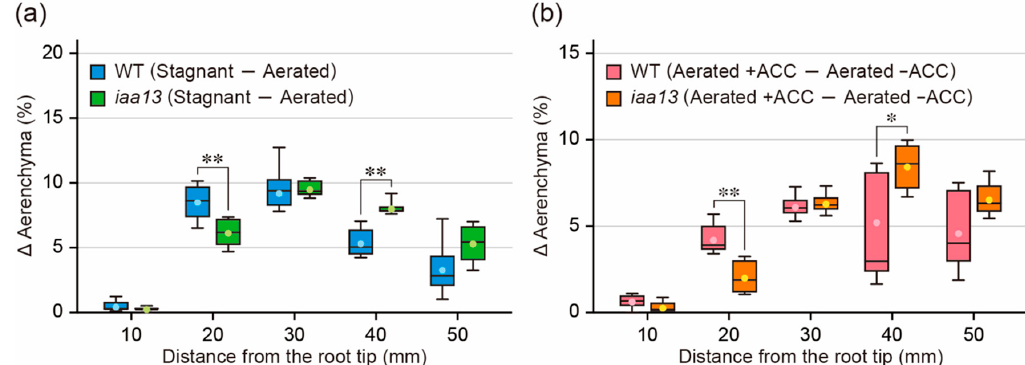
Figure 3. Di ff erences in aerenchyma formation between under aerated and stagnant conditions and between aerated conditions with and without 1-aminocyclopropane-1-carboxylic acid (ACC) treatment. ( a , b ) Di ff erences in the percentages of aerenchyma (D Aerenchyma (%)) in root cross-sectional area at 10, 20, 30, 40, and 50 mm from the tips of adventitious roots of the wild type (WT) and iaa13 mutant. The di ff erences in the percentages of aerenchyma were calculated by the data obtained in Figures 1a and 2b, respectively. ( a , b ) Significant di ff erences between the genotypes at p < 0.05 and p < 0.01 are denoted by * and **, respectively (two-sample t -test). Boxplots show the median (horizontal lines), 25th to 75th percentiles (edges of the boxes), minimum to maximum (edges of the whiskers) and mean values (dots in the boxes) ( n =